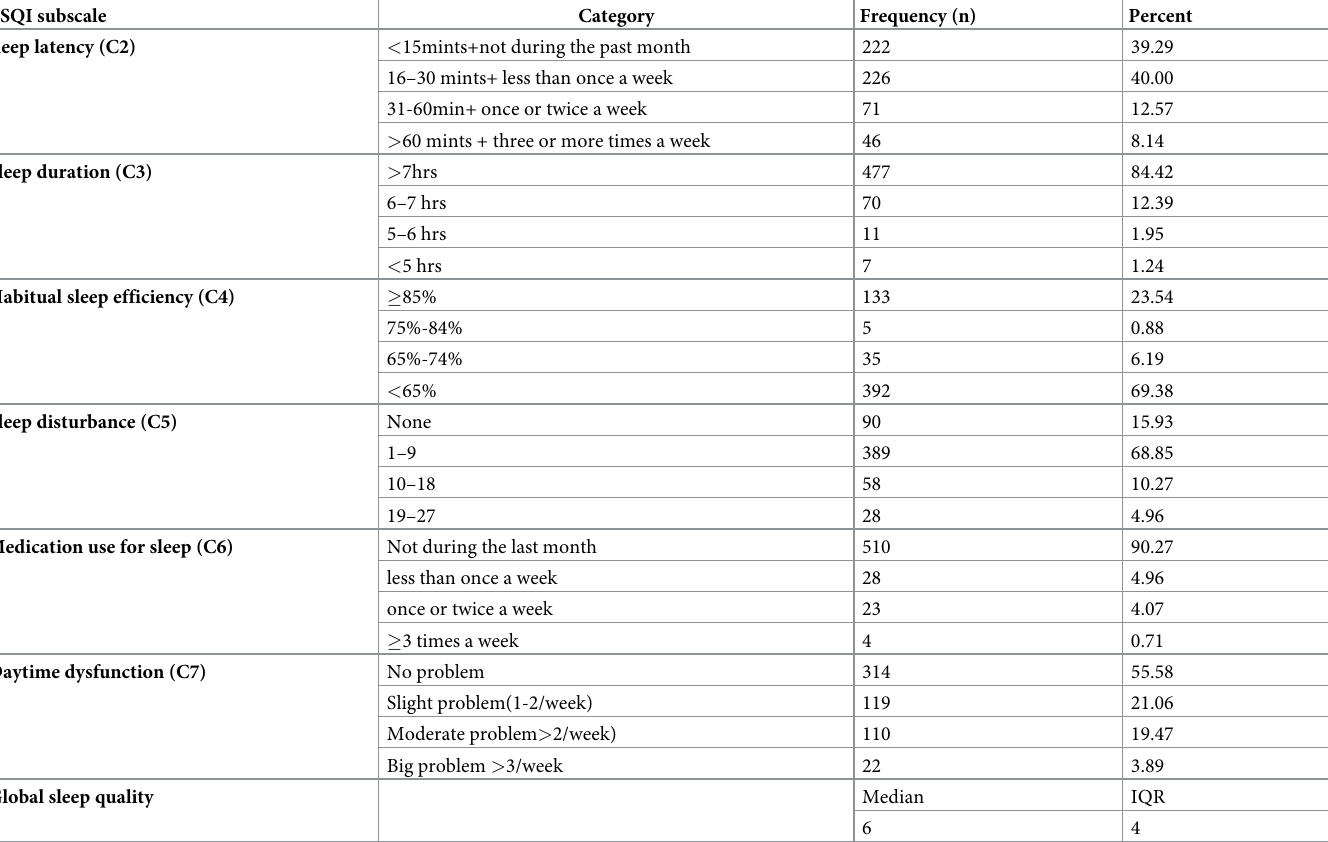
Table 4. The Pittsburgh Sleep Quality Index (PSQI) subscale scores among adult epileptic patients attending follow-up care at referral hospitals in Amhara region, Ethiopia, 2021. PSQI